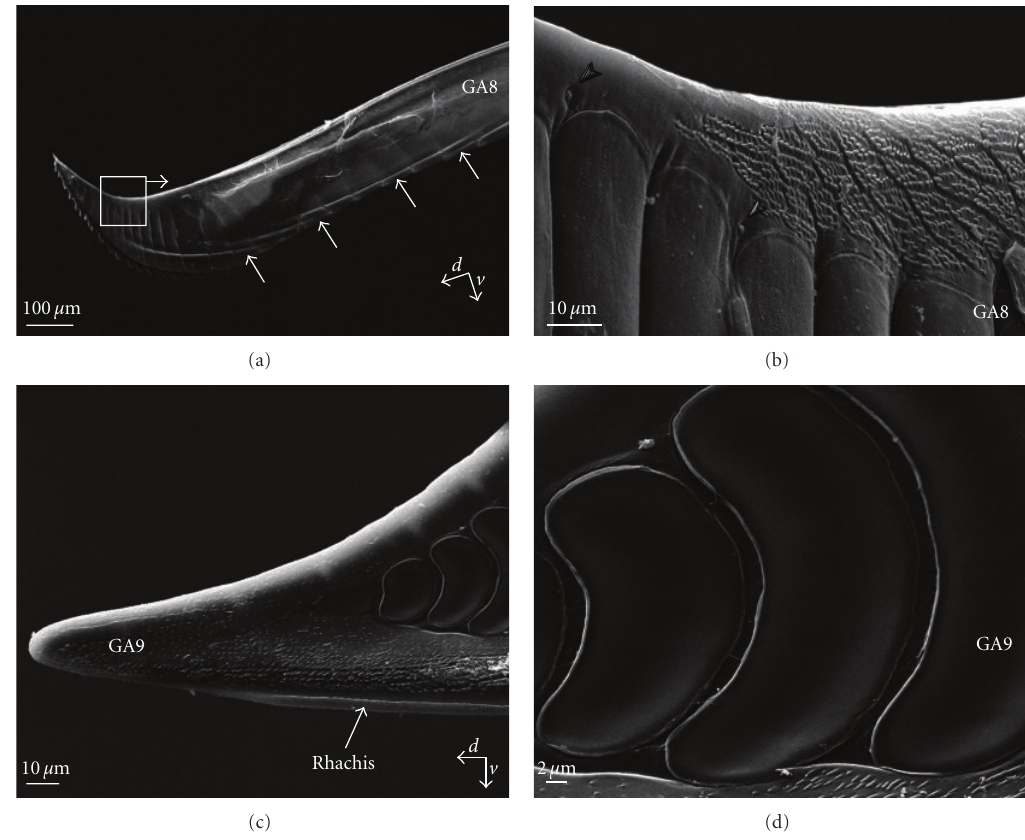
Figure 4: SEM micrographs of the inside surface of gonapophyseal apices in Tricholepidion gertschi : (a) distal part of the 8th gonapophysis (inset is enlarged in (b)); (b) dorsal margin of the 8th gonapophysis showing smooth tablet-like fields and short microtrichia above; (c) apical part of the 9th gonapophysis with tablet-like fields and short microtrichia below; (d) subapical part of the 9th gonapophysis showing smooth tablet-like fields. Arrowheads indicate dome-shaped sensilla. Arrows indicate ventral corrugations of the 8th gonapophysis. GA8 and GA9: the gonapophyses of 8th and 9th segments, respectively. d and v : distal and ventral directions,